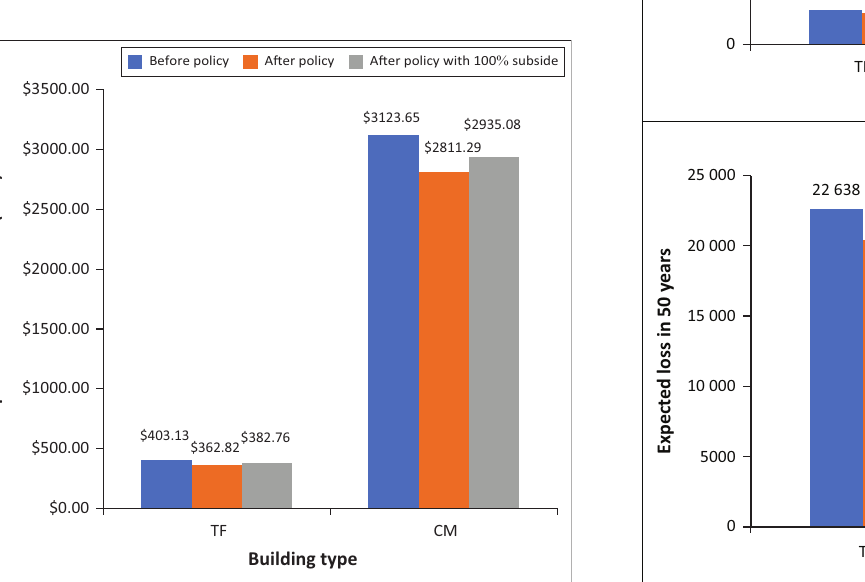
CM, confined masonry; TF, timber frame; USD, United States Dollar. FIGURE 10: Comparison of risk calculation in terms of economic loss for confined masonry and timber frame buildings before and after applying policy.